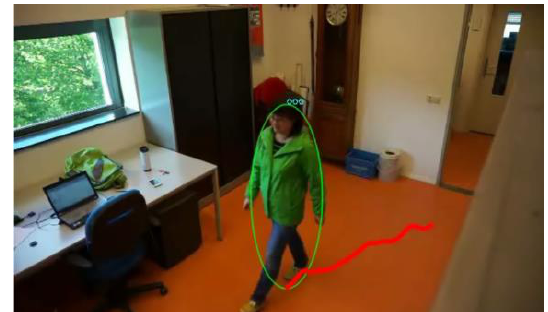
Figure 3: Tracking a human